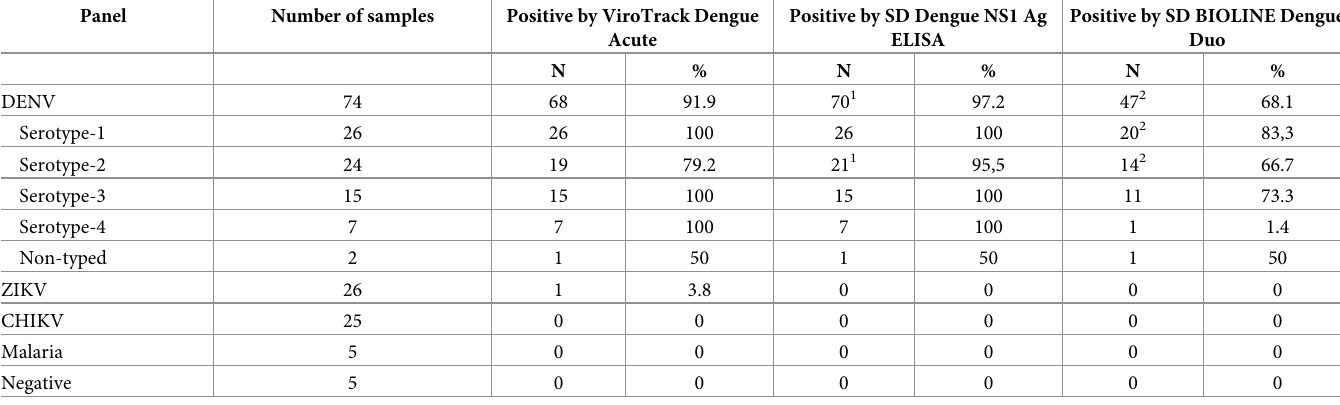
Table 2. Positive results from the total of positive samples tested.